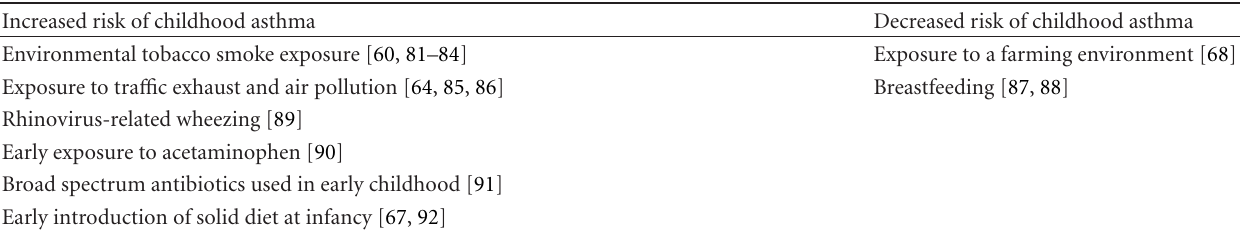
Table 3: Postnatal environmental factors associated with risk of childhood